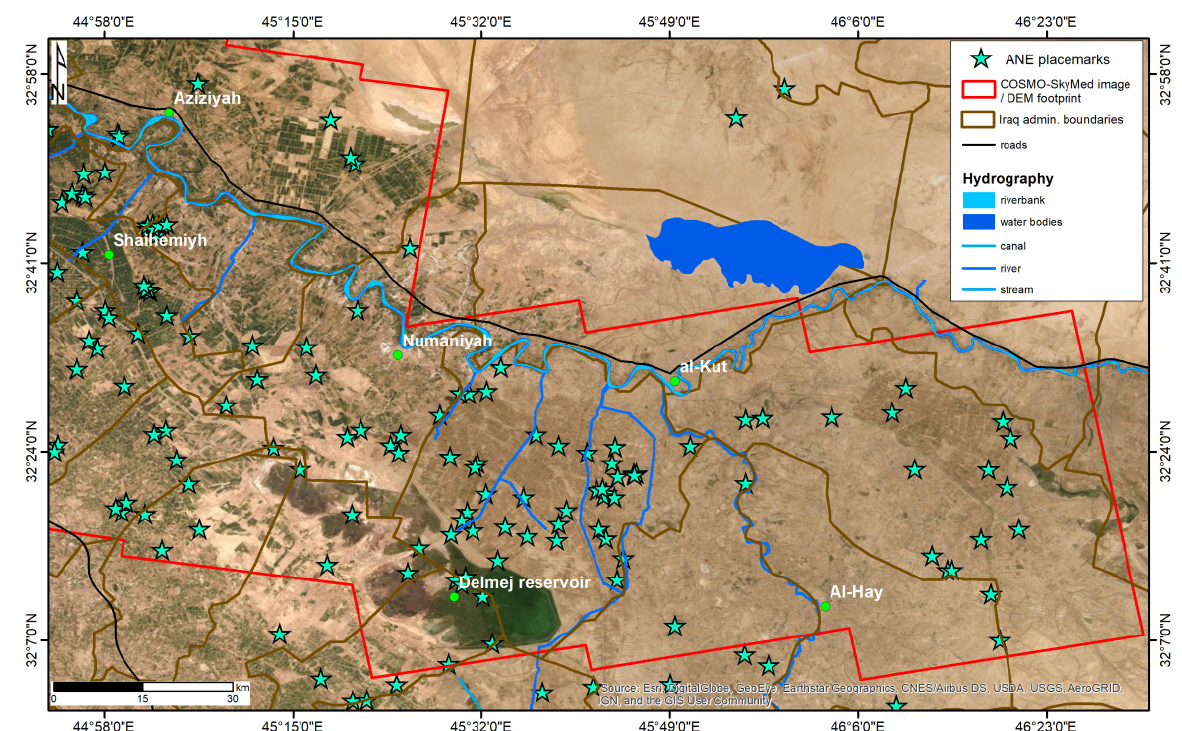
Figure 3. Spatial distribution of placemarks of Ancient Near East (ANE) sites as mapped by [70]. The density of mapped features decreases going toward the east from the Dejmej reservoir. Iraq administrative boundaries, roads, and waterways from OpenStreetMap.org, onto ArcGIS basemap image.